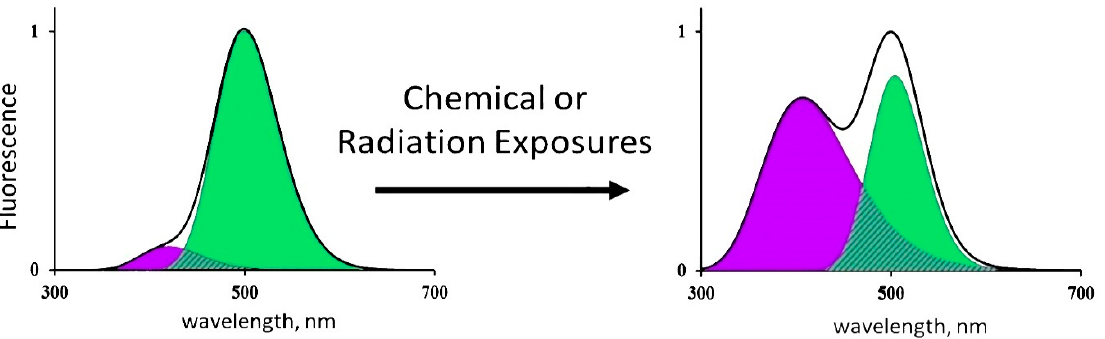
Figure 2. Changes in the fluorescence spectrum of CLM-FP exposed to chemical agents or radiation [16]. Adapted from Kudryasheva, N.S.; Kovel, E.S. Monitoring of low-intensity exposures via luminescent bioassays of different complexity: Cells, enzyme reactions, and fluorescent proteins. Int. J. Mol. Sci. 2019 , 20 , 4451.